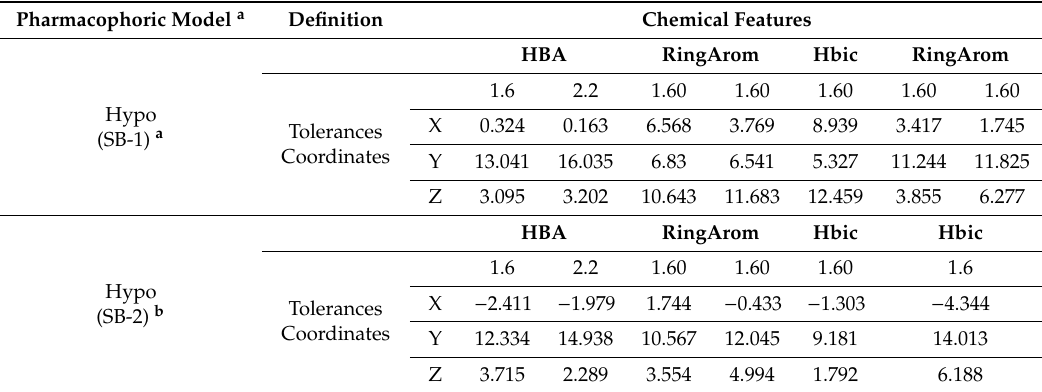
The three-dimensional (3D) coordinates and feature tolerances of dbCICA-derived pharmacophore